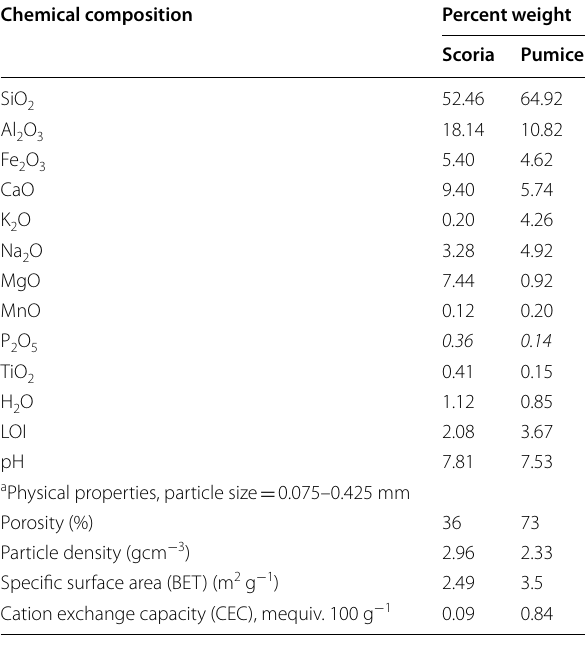
Table 1 Physical and chemical characteristics of scoria and pumice